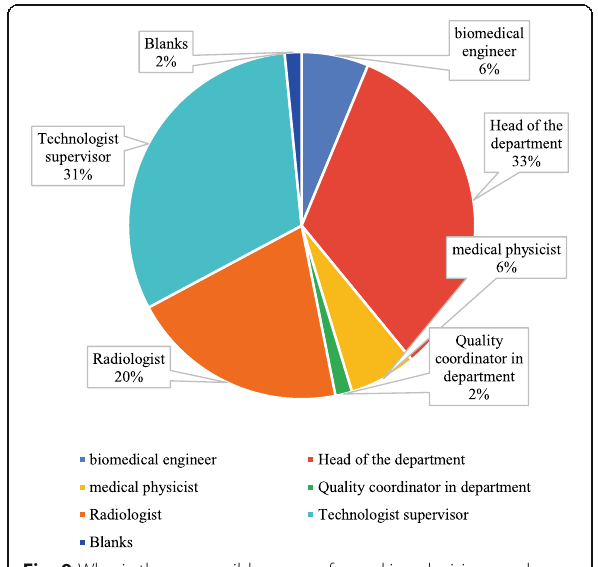
Fig. 9 Who is the responsible person for making decisions